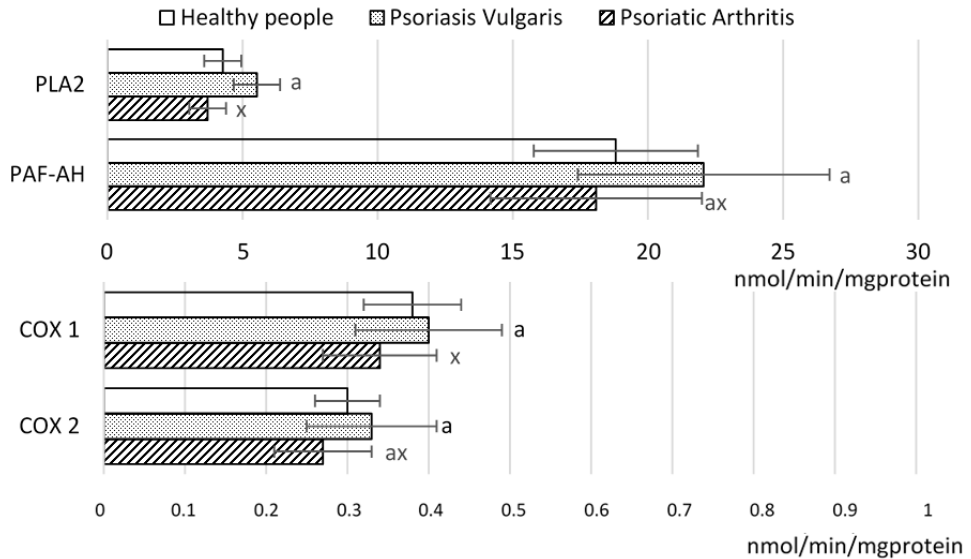
Figure 3. The activity of the enzymes involved in phospholipid metabolism in mononuclear cells of patients psoriasis vulgaris (n = 32) and psoriatic arthritis (n = 16) as well as healthy subjects (n = 16). PLA2, phosholipase A2; PAF-AF, platelet-activating factor acetylhydrolase; COX, cyclooxygenases. Data points represent the mean ± SD; a, significantly different from healthy subject, p < 0.05; x, significantly different from patients with psoriasis vulgaris, p < 0.05 .